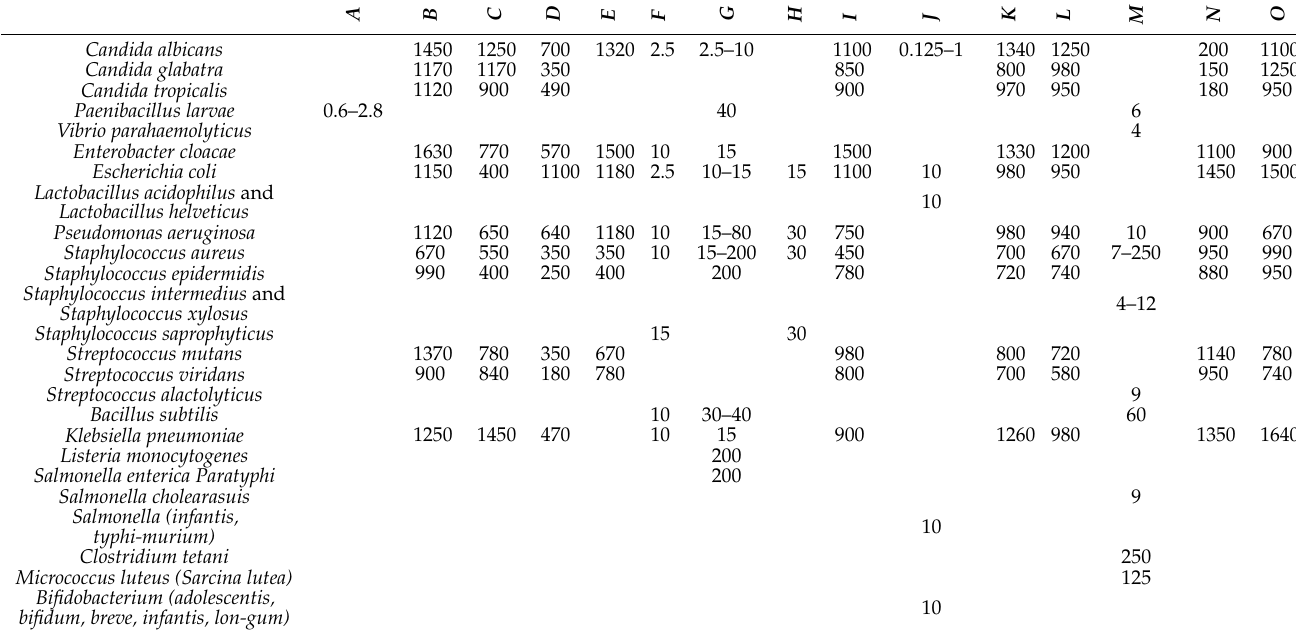
Table 2. Antimicrobial activity of RJ compounds in terms of minimal inhibitory concentration (MIC) ( µ g/mL). Based on